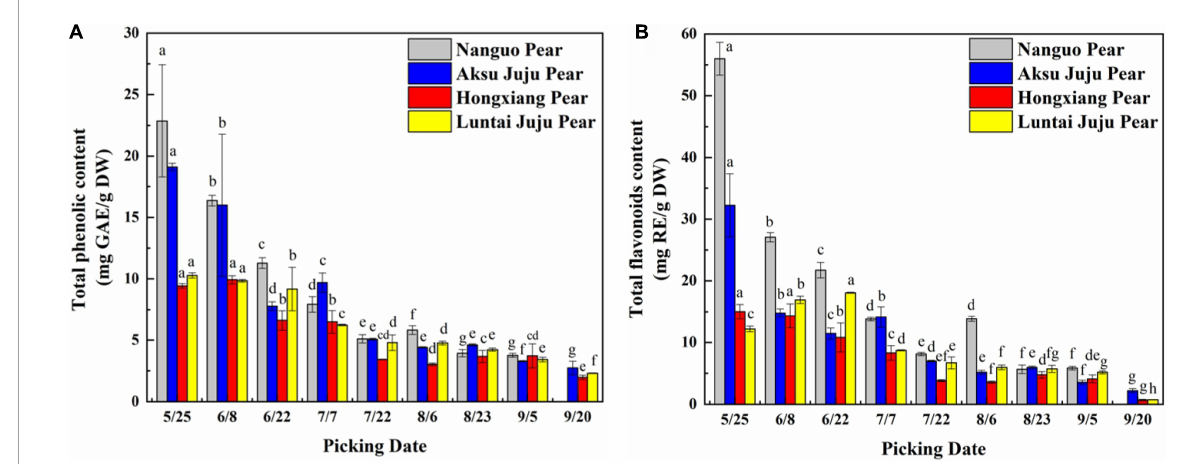
FIGURE2 Changes in the TPC and TFC in pear fruits. (A) Total phenol content; (B) total flavonoid content (mean ± SD, n = 3). Bars with different letters differ significantly ( p < 0.05).